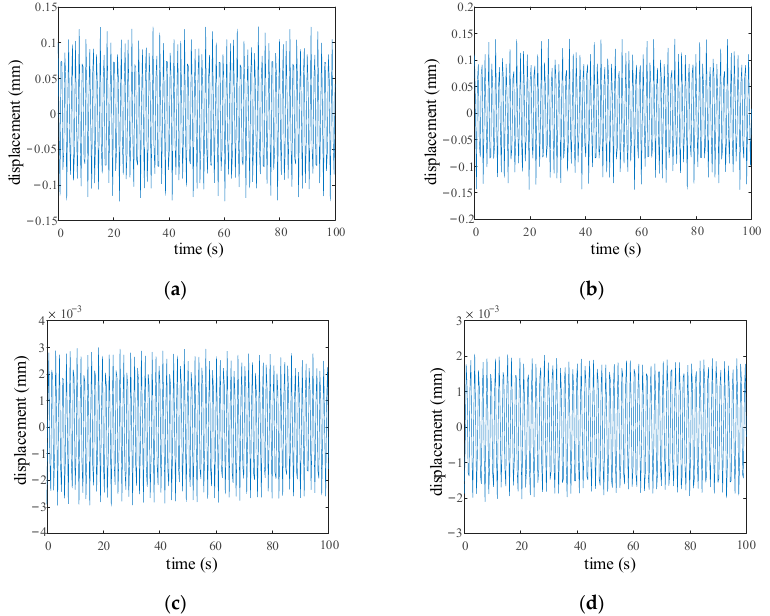
Figure 6. The time domain response of some components in the first stage. ( a ) Rotational displacement u p11 of the planetary gear; ( b ) rotational displacement u p31 of the planetary gear; ( c ) radial displacement η p31 of the planetary gear; ( d ) horizontal displacement X c1 of the carrier.